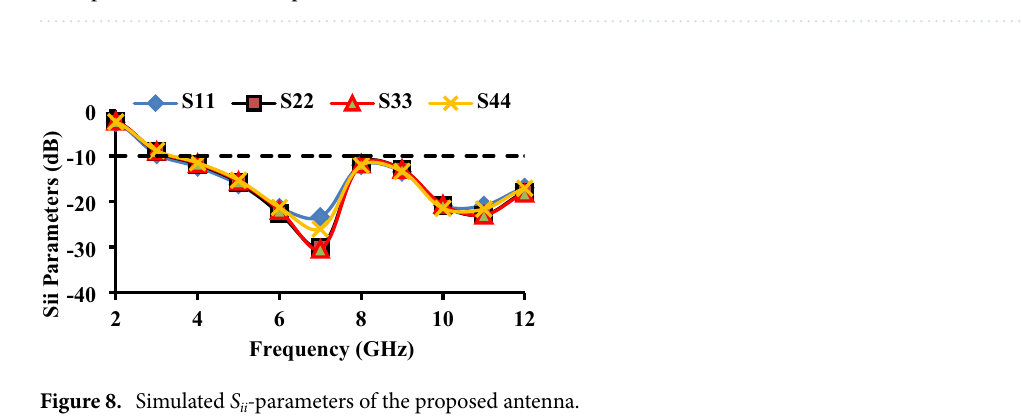
Figure 7. Proposed MIMO/diversity antenna ( a ) without connected ground plane, ( b ) with connected ground (CG) plane, ( c ) Simulated S-parameters.